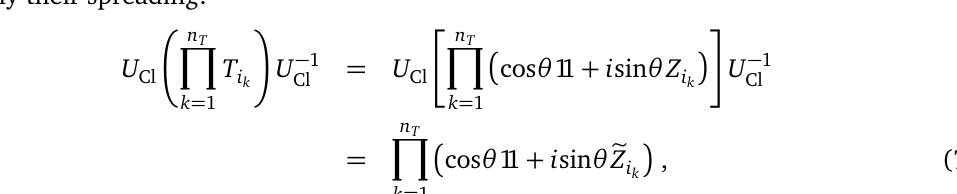
r ( τ → ∞ ) 〉 versus n Figure 6: The infinite-time average 〈 (cid:101) = U − 1 in which U (cid:48) , for systems sizes N = 12,14,16,18 and 20. All curves collapse Cl Cl / N 0.6 ) interpolating between r 〉 = g ( n to a universal scaling function 〈 (cid:101) T ≈ 0.6. The numbers of realizations are the same as in Fig. 4. When not r and (cid:101) GUE visible, the error-bars are smaller than the size of the data